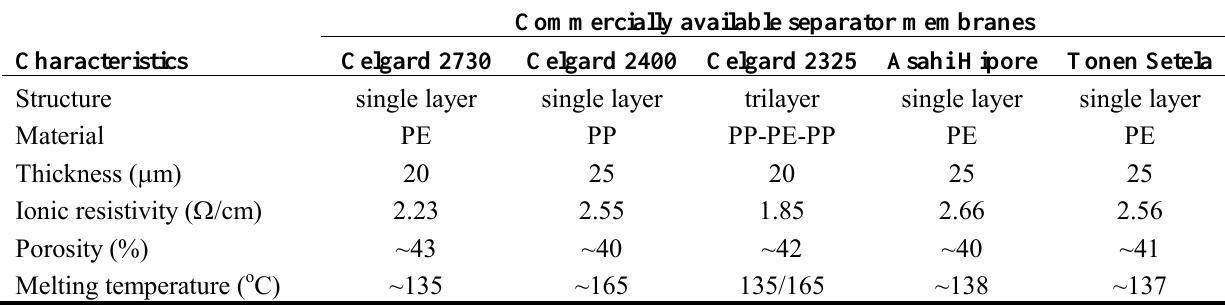
Table 1. Physical properties of commercial polyolefin membranes as the separators for LIPB. Adapted with permission from Reference [4]. © 2004 American Chemical